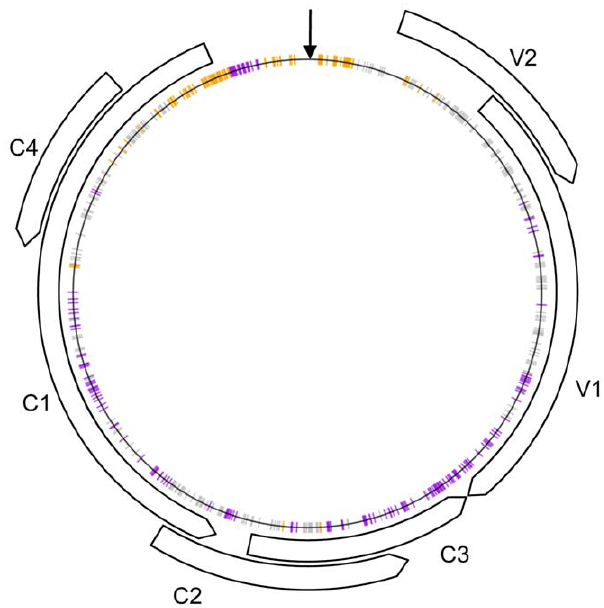
Figure 2. Schematic representation of the recombinant ge- nomes indicating nucleotide positions at which more than expected Tomatoyellowleafcurlvirus (TYX; orange) or Tomato leafcurlComorosvirus (TOX; purple) derived nucleotides are found ( p -value , 0.001) under the assumption of random recombination. Polymorphic nucleotide sites indicated in grey represent those sites at which no preference for TYX or TOX derived nucleotides is evident. The positions of various open reading frames and the origin of replication (V-Ori) are indicated with arrows.